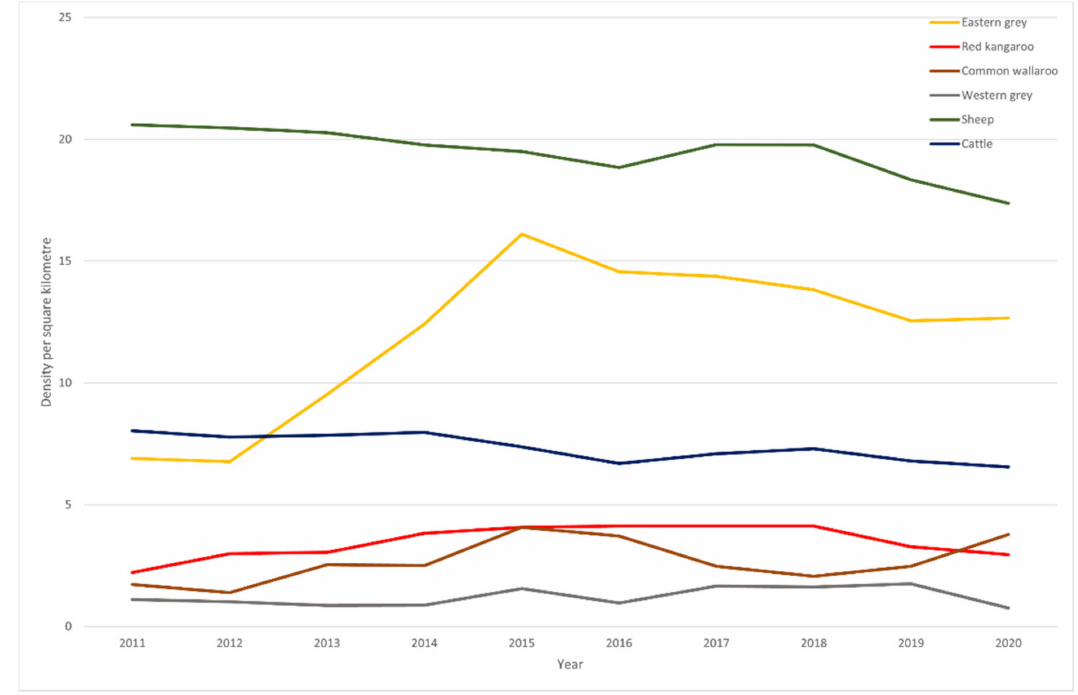
Figure 7. Estimates of the density of sheep, cattle, eastern grey kangaroos, red kangaroos, common wallaroos and western grey kangaroos in the combined grazing areas or survey areas of Queensland, New South Wales, South Australia and Western Australia from 2011–2020 (sources as for Figure 3